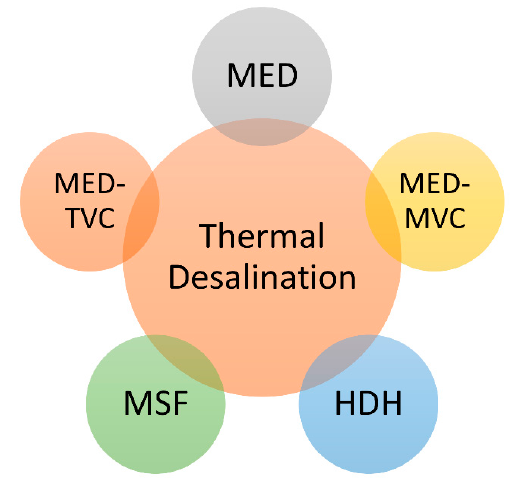
Figure 2. Classification of main thermal-driven desalination technologies. HDH, humidification- dehumidification; MED, multi-effect distillation; MSF, multi-stage flash; MVC, mechanical vapor compression; TVC, thermal vapor compression.